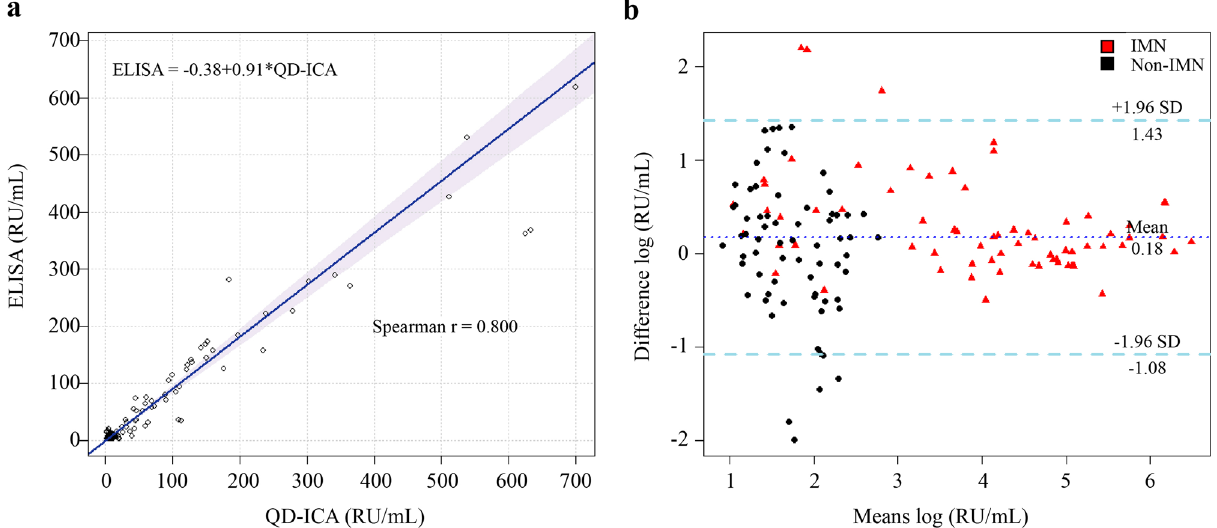
Figure 3. Consistency analysis for QD-ICA and ELISA. ( a ) Comparison of Passing and Bablok regression analyses for the two assays (regression equation was Y = 0.91x − 0.38, the Spearman correlation coefficient r